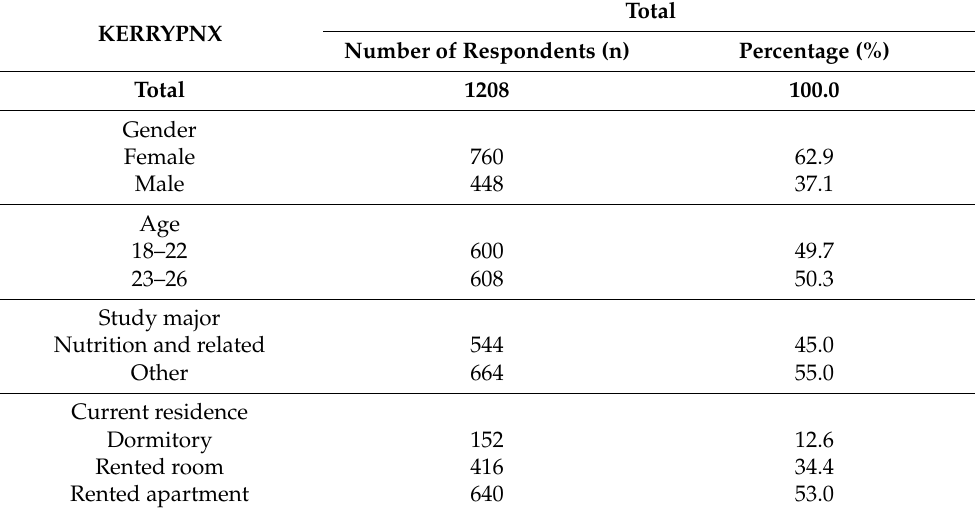
Table 1. Characteristics of the study